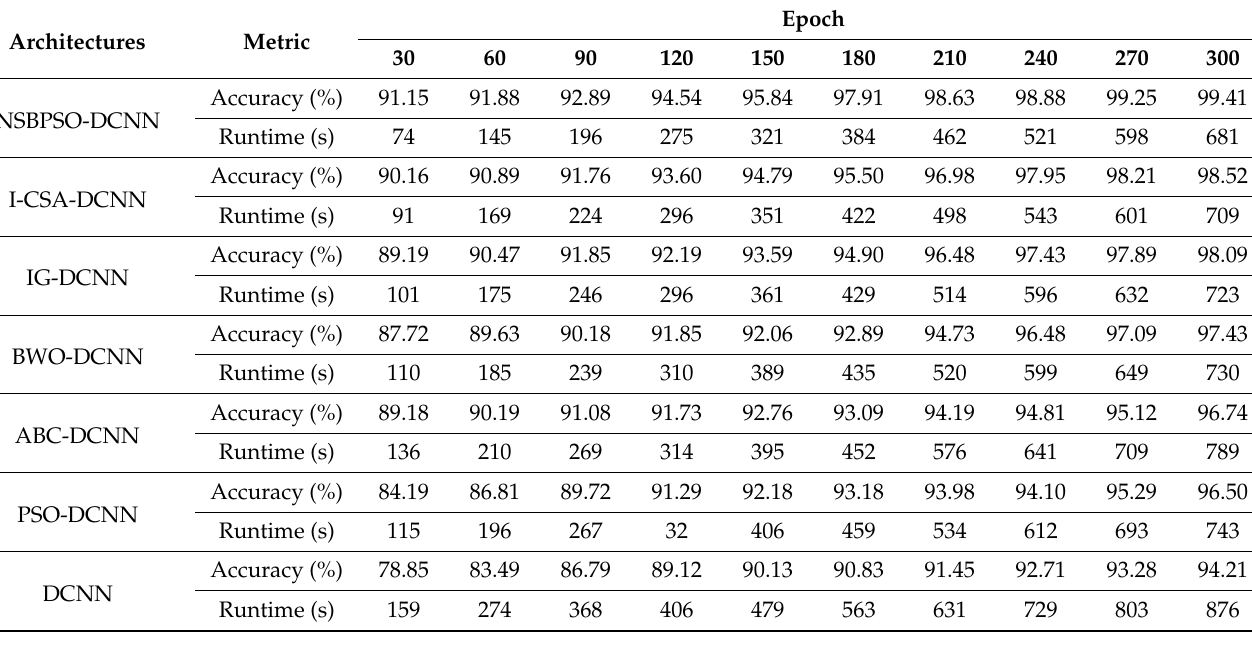
Table 4. Accuracy and runtime of the models for different epochs.